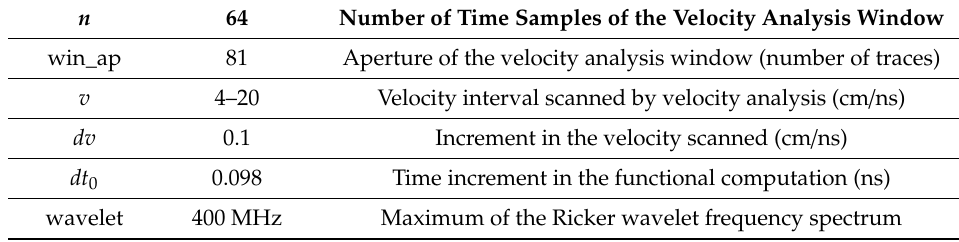
Table 2. Parameters used in the velocity analysis on real data by the di ff erent